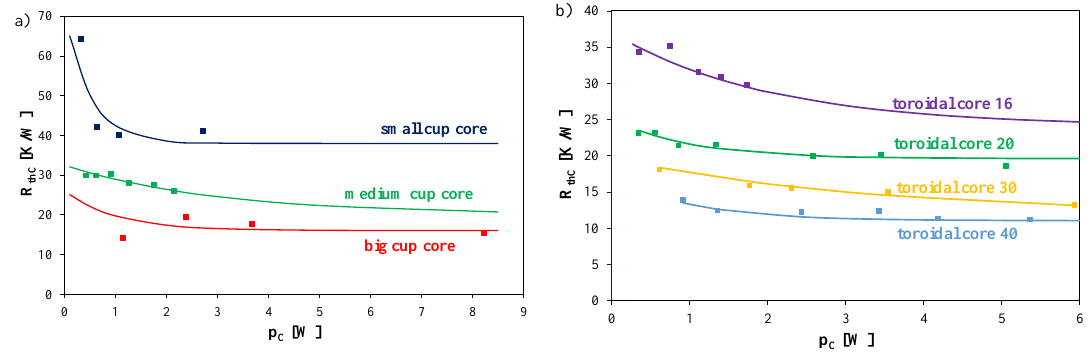
Figure 13. Measured and calculated dependences of thermal resistance R thC of inductors with ( a ) cup cores and ( b ) toroidal core on dissipated power in the core.